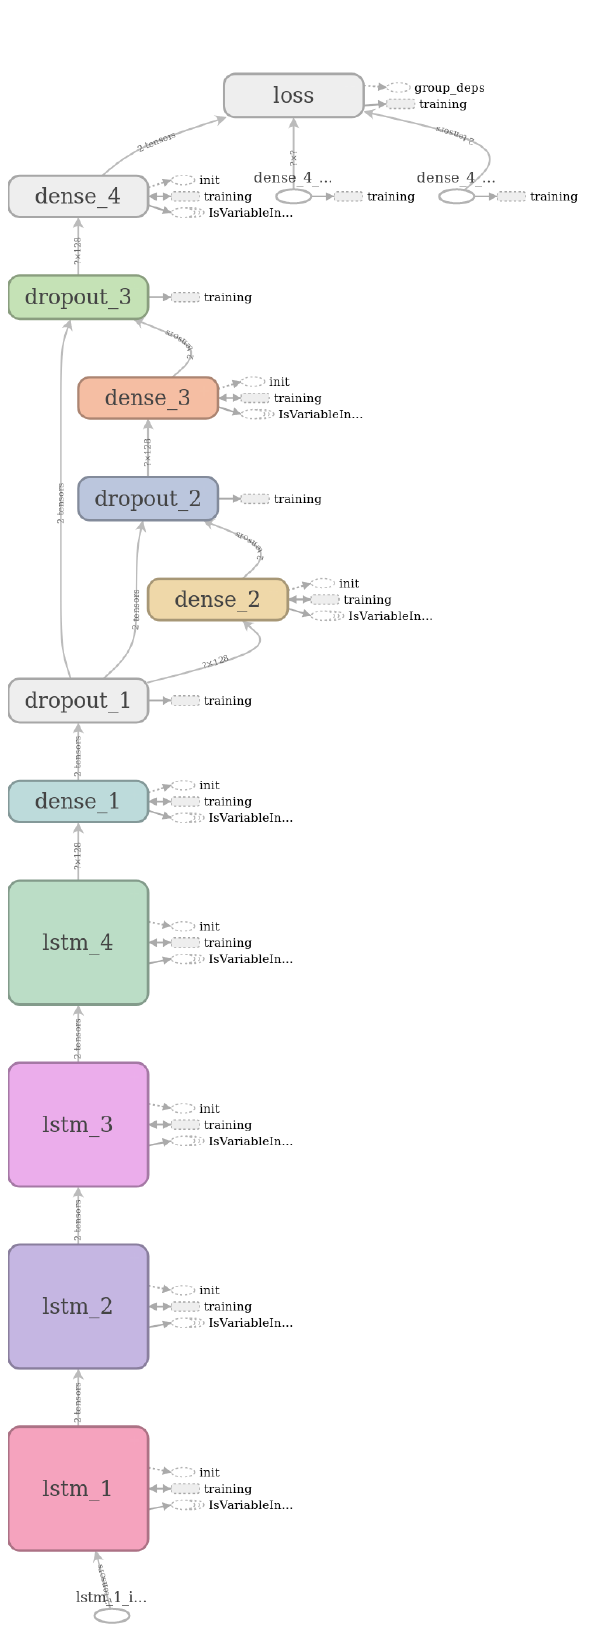
Figure 8. Graphical visualization of the resulting classification model used by the Arrhythmia Classification Module generated by the TensorBoard graphical